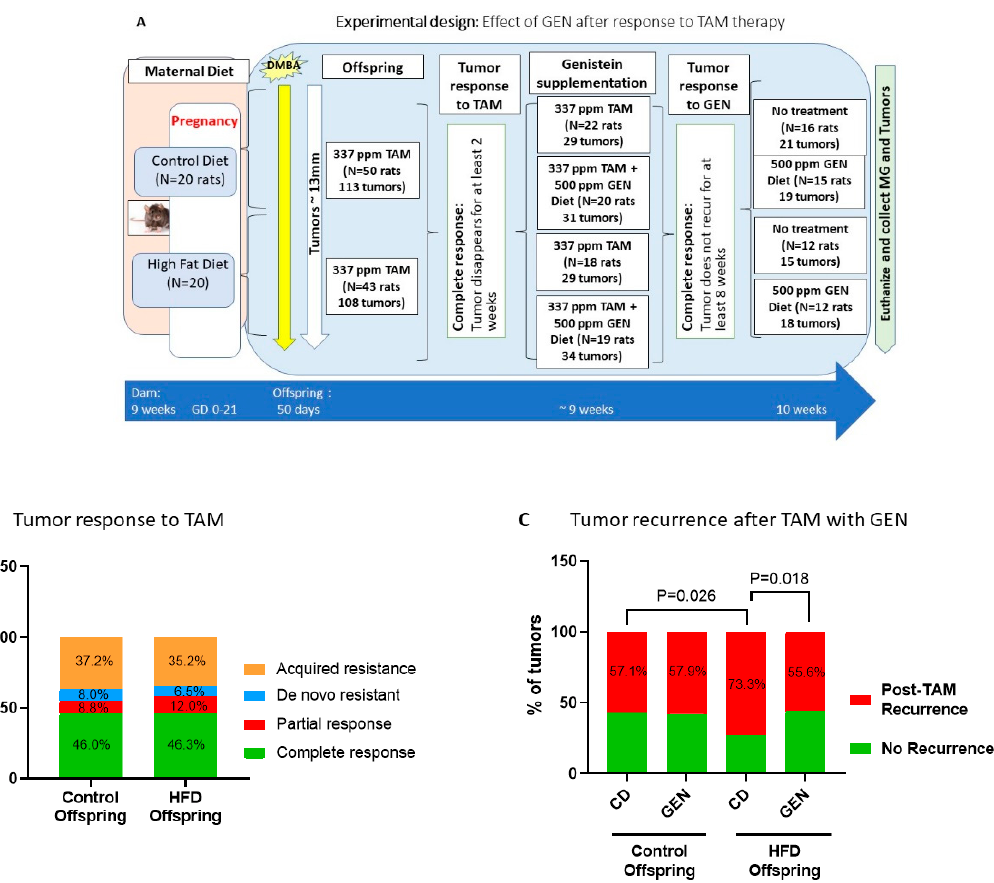
Figure 2. Genistein (GEN) after tamoxifen response prevents local recurrence in the HFD offspring. ( A ) Experimental design to study the effects of starting genistein feeding after complete response to tamoxifen on local mammary tumor recurrence in the offspring of control or high fat diet (HFD) fed dams. ( B ) Maternal exposure to HFD did not change initial response to tamoxifen (HFD, n = 108 tumors), compared to control offspring ( n = 113 tumors). ( C ) After tamoxifen therapy, there was no difference in tumor recurrence among control offspring treated with GEN (con/GEN; out of 19 tumors) or not treated with GEN (control/CD; out of 21 tumors). Maternal HFD significantly increased ( p = 0.026) mammary tumor recurrence after tamoxifen therapy (HFD/CD; out of 15 tumors), compared with control offspring. GEN supplementation significantly decreased ( p = 0.018) tumor recurrence in the HFD offspring (HFD/GEN; out of 18 tumors). The data are shown as percentage of tumors. Statistical significance according to Chi-Square test.